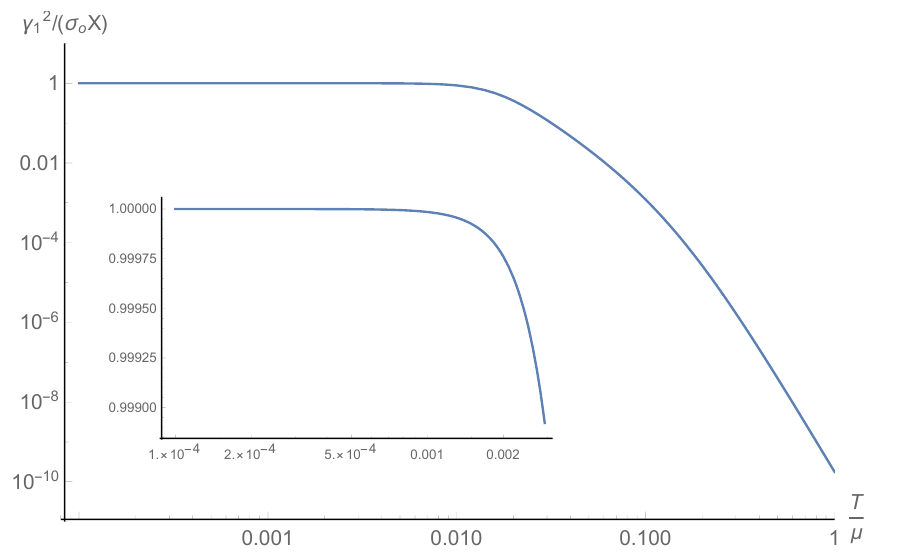
(cid:20) (cid:27) o X holds. At low temperatures, the 1